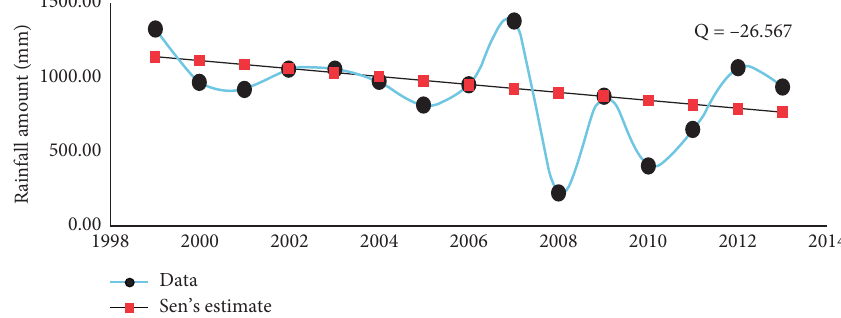
Figure 2: Total annual rainfall trend in the Bawku Municipality in the past 15 years.